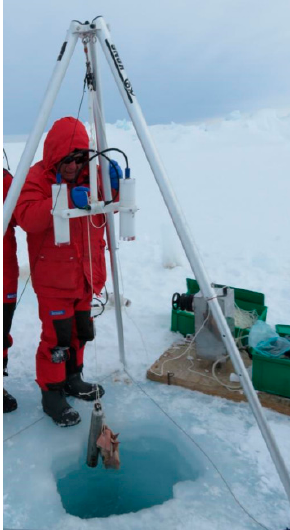
Figure 2. Essential structure of the mini-BRUV system . The prototype was deployed through ice holes of about 40 cm diameter. holes of about 40 cm